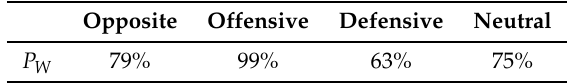
Table 3. Probability of winning P W of the air combat